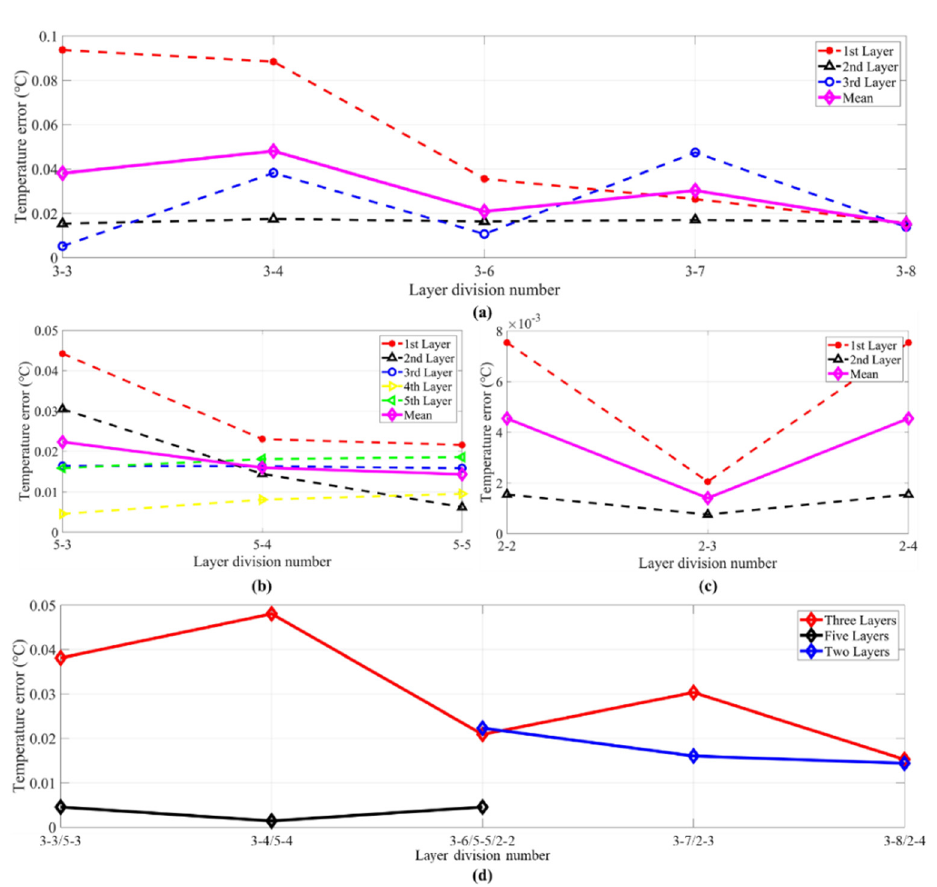
Figure 18. Inversion errors of the second group of S1–S2 . The meanings of ( a – d ) are the same as in Figure 16a–d.